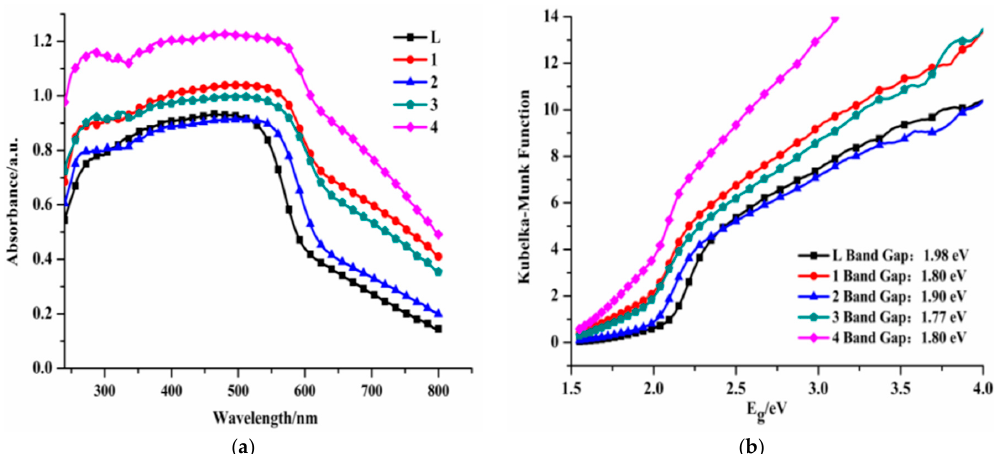
Figure 8. Solid state UV-vis absorption spectra ( a ) and Kubelka-Munk diffuse reflectance spectra ( b ) for L and complexes 1 – 4 .